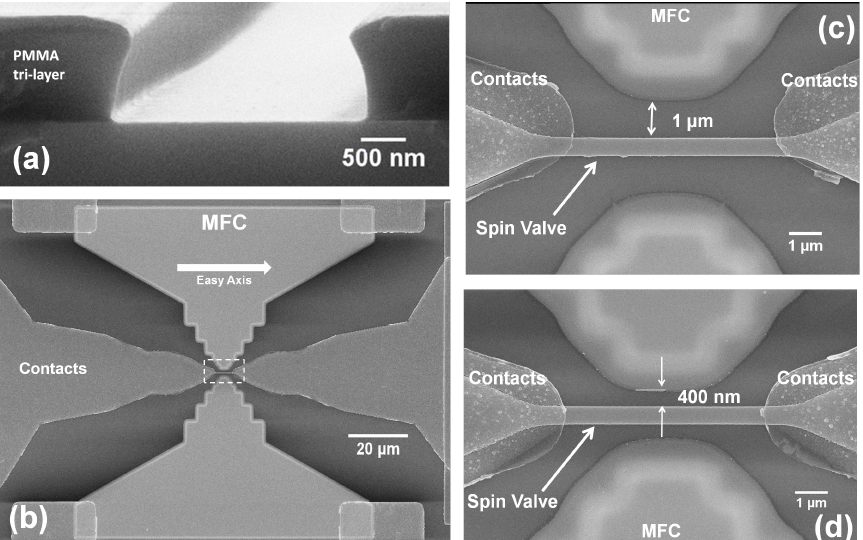
Figure 2. ( a ) Cross section SEM view of the tri-layer PMMA after electron beam lithography (EBL) exposure and development; ( b ) SEM top view of the full device and ( c , d ) detailed view of the largest and smallest gaps and sensor to pole distances fabricated using this